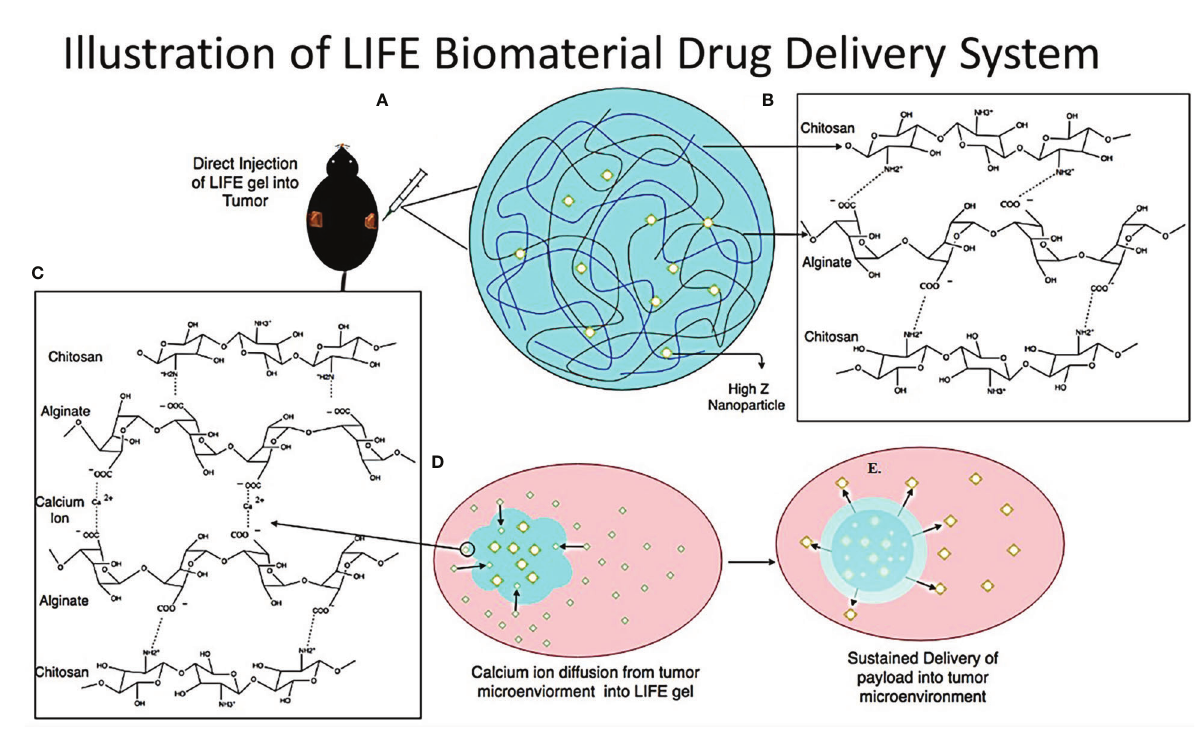
FIGURE 1 The LIFE biomaterial consists of a mixture of sodium alginate gel and chitosan gel made in a 1:1 ratio in addition to 10% of nanoparticle solution (either titanium dioxide for CT contrast or AGuIX gadolinium-based nanoparticles for MR contrast) to the polymer mixture (B) to enable image contrast during radiotherapy treatment. This fi gure highlights the molecular structure and ionic interaction between chitosan and sodium alginate polymers (C) . Once the LIFE biomaterial is injected in the tumor site using an insulin syringe with a (22-Gauge) needle attached (A) , the gel congeals within the calcium-rich tumor micro-environment as illustrated in fi gure 1 (D, E)